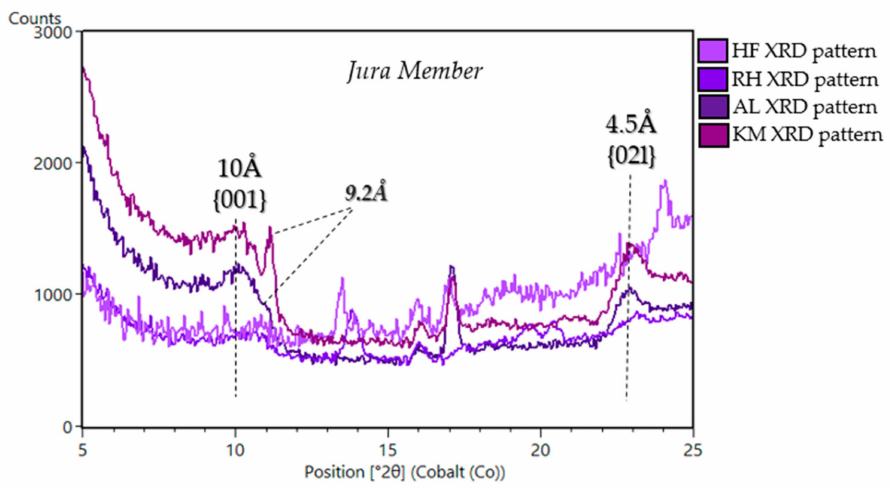
Figure 16. CheMin XRD patterns from 5 ◦ to 25 ◦ 2 θ of samples from the Jura member (VRR—HF and RH, and GT—AL and KM). The position of the d(001) and d(02l) peaks are denoted by dashed black